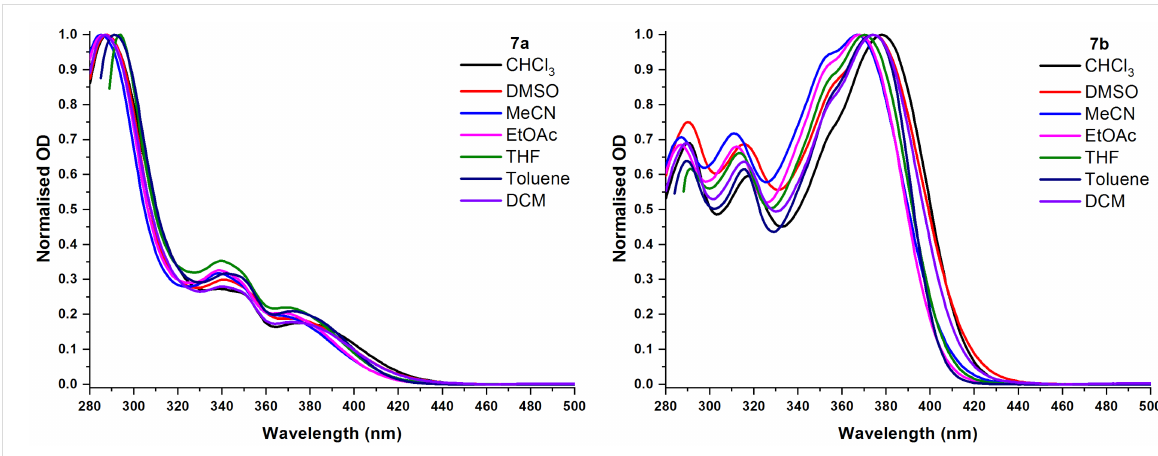
Figure 5: Normalised UV–vis spectra of compounds 7a and 7b in different solvents.